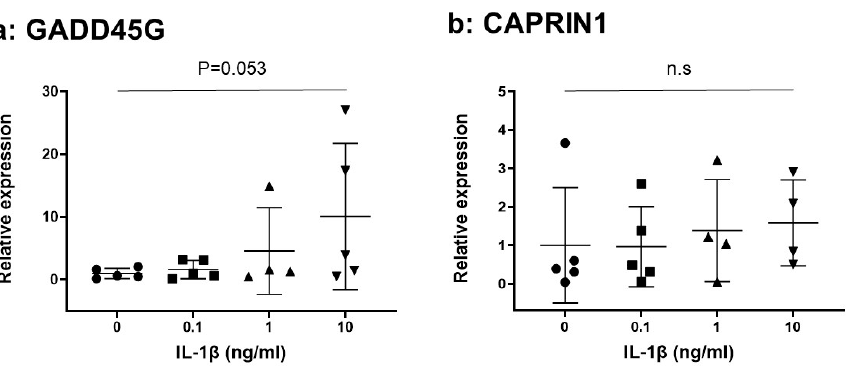
Figure 5. Effect of interleukin-1 beta (IL-1 β ) on the mRNA expression of GADDD45G ( a ) and CAPRIN1 ( b ) in human nucleus pulposus (NP) cells (n = 5). n.s not significant.